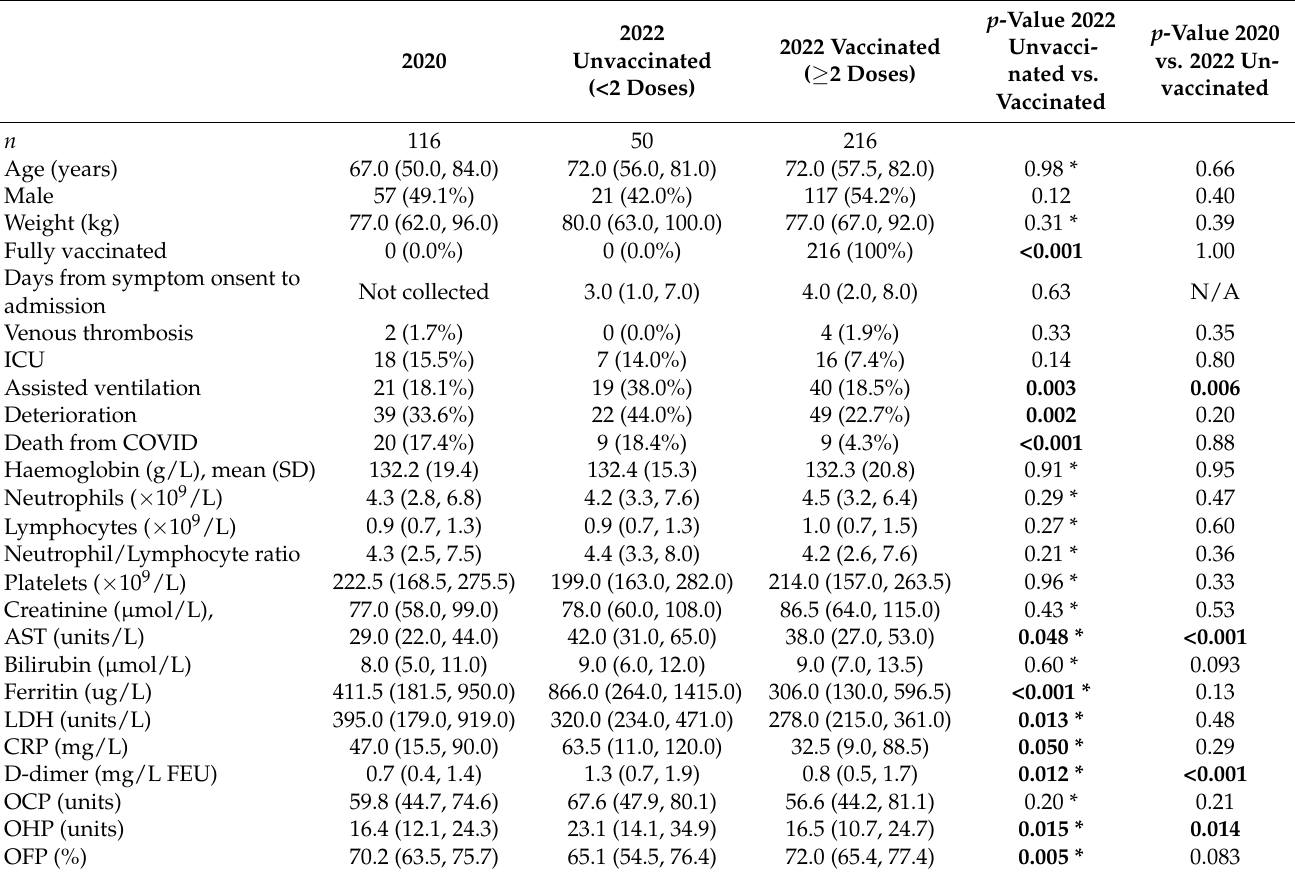
Table 3. Baseline characteristics, laboratory results and clinical outcomes of COVID-19 patients from 2022 categorized by vaccination status. Data are n (%), and median (interquartile range, IQR), unless specified